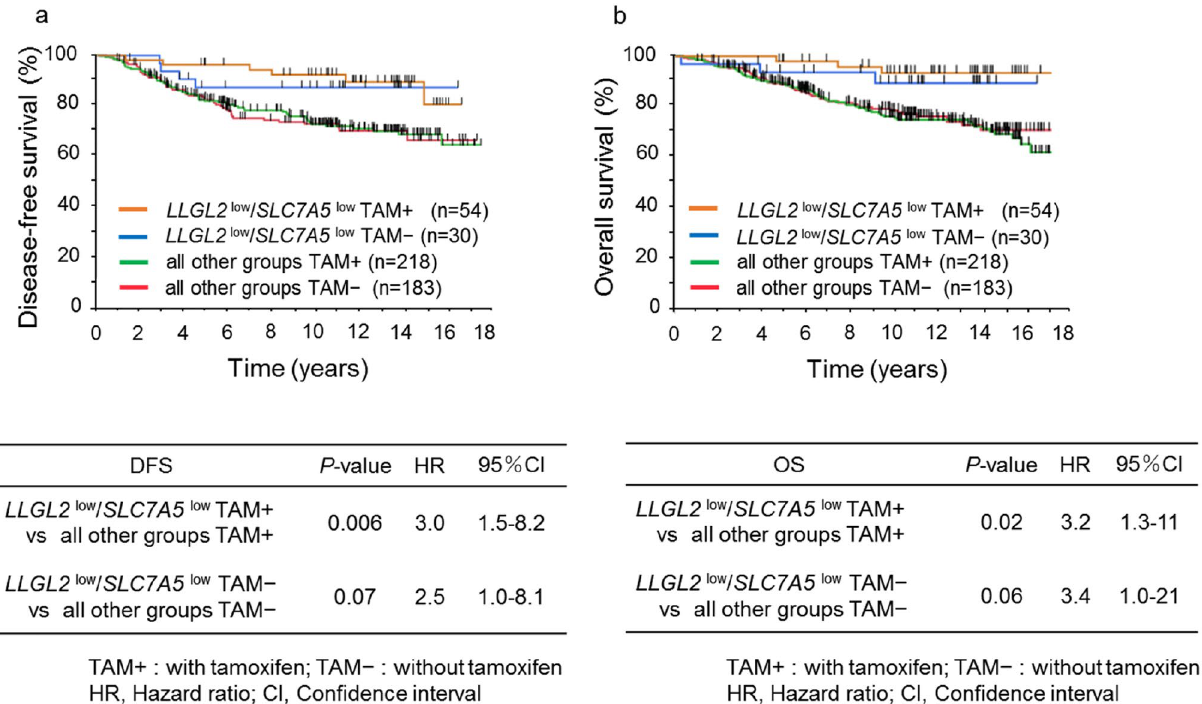
Figure 2. Kaplan–Meier survival curves according to LLGL2 low / SLC7A5 low versus all other groups with and without adjuvant tamoxifen therapy. Graphs show DFS and OS curves ( a,b